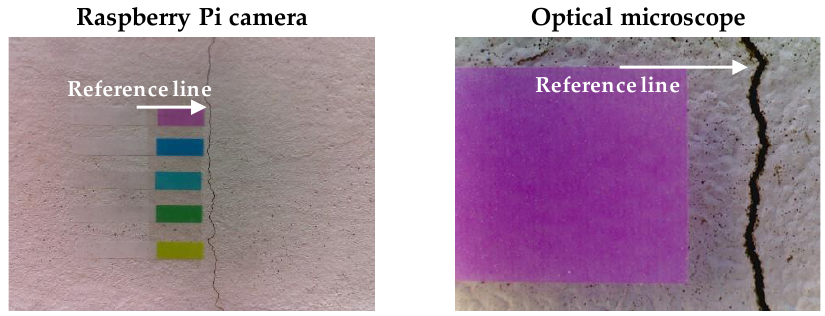
Figure 7. Comparison of detected crack widths to references.